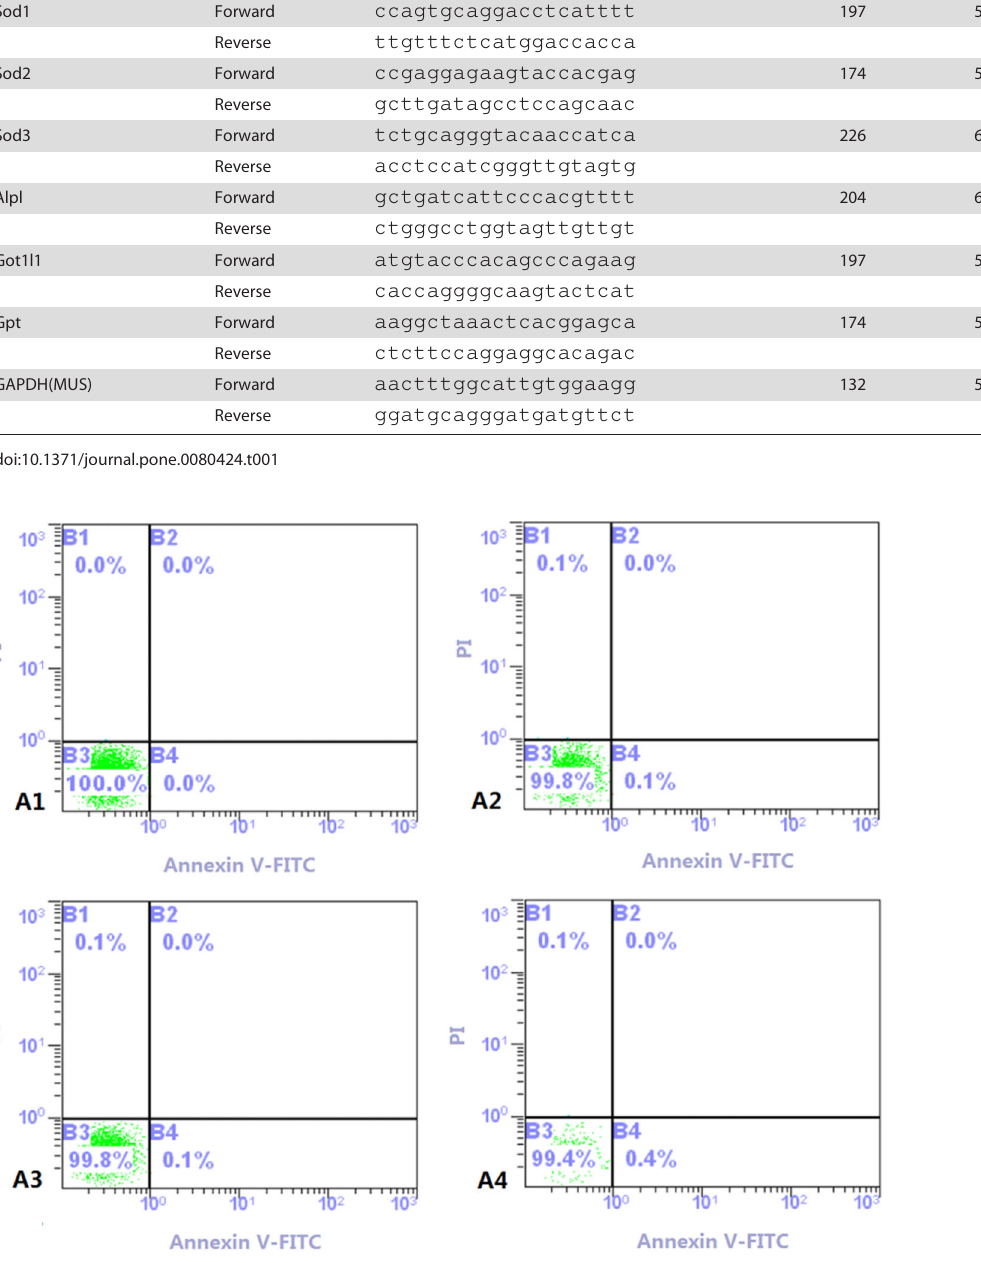
Figure 1. The variation of apoptosis rate in Swiss rats under the effect of Cry1Ab protein. A1: the 30 day feeding Swiss rats in control group. A2: the 90 day feeding Swiss rats in control group. A3: the 30 day feeding Swiss rats in test group. A4: the 90 days feeding Swiss rats in test group. Note: The X coordinate means the percent of dyeing Annexin V cells. The Y coordinate means the percent of dyeing PI cells. The B1 coordinate means the percent of necrosis cells and the late apoptosis cells. The B2 coordinate means the percent of dead cells of mechanical damage. The B3 coordinate means the percent of survived cells. The B4 coordinate means the percent of the early apoptosis cells. doi:10.1371/journal.pone.0080424.g001 PLOS ONE |